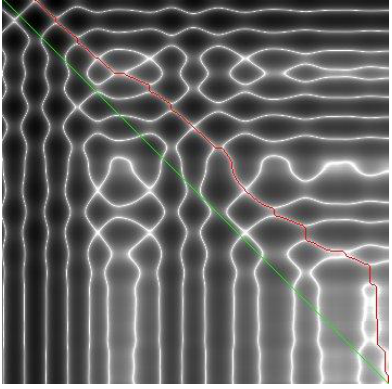
Fig. 4. Example of a portion of the time warping cost matrix.